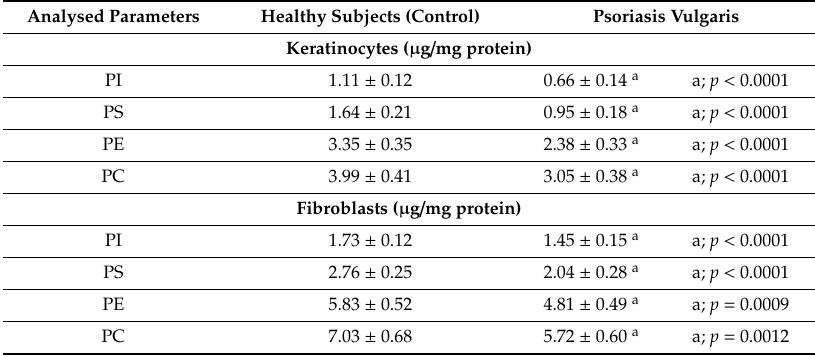
Table 1. The level of phospholipid fractions (phosphatidylinositol (PI), phosphatidylserine (PS), phosphatidylethanolamine (PE), phosphatidylcholine (PC)) in keratinocytes and fibroblasts of patients with psoriasis vulgaris ( n = 16) as well as healthy subjects ( n = 8).